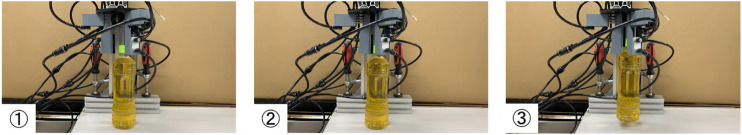
Gripping and releasing a 0.525 L PET bottle with three-fingered pneumatic gripper.